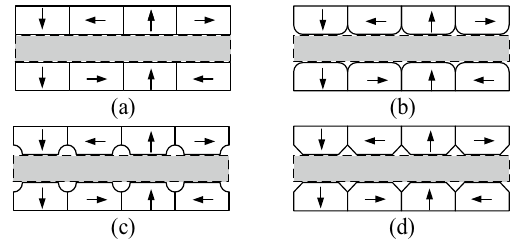
Figure 21 Halbach arrays with various shapes of magnets: a Right angle, b Round, c Fillet, and d Rectangular chamfered